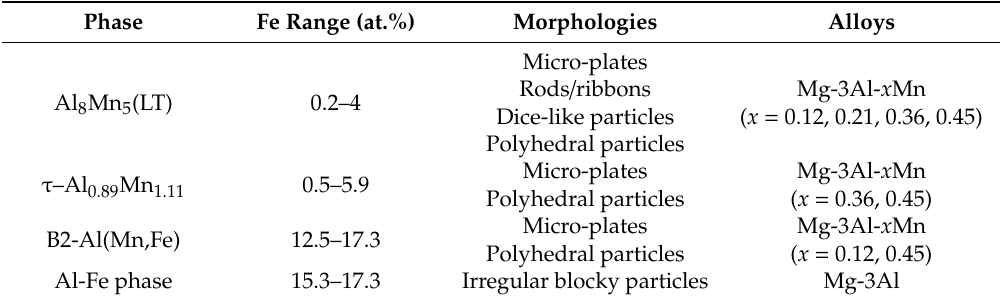
Table 3. Summary of the phases, Fe content, and morphologies of the Al-containing intermetallic particles based on EPMA and SEM